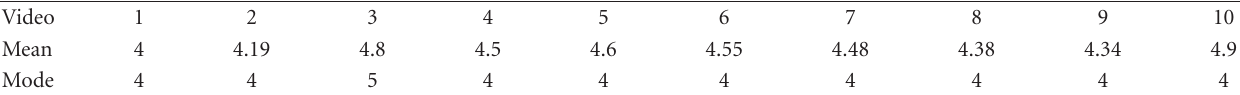
Table 3: Rating of lymphedema therapists for video content validity. Rating scale was 5: strongly agree to 1: strongly disagree.